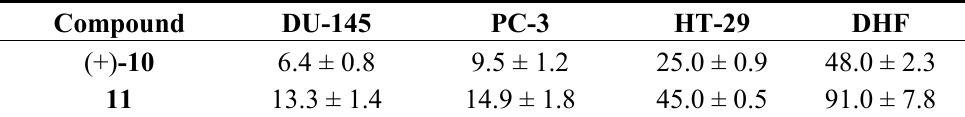
µM) of (+)- 10 and 11 50